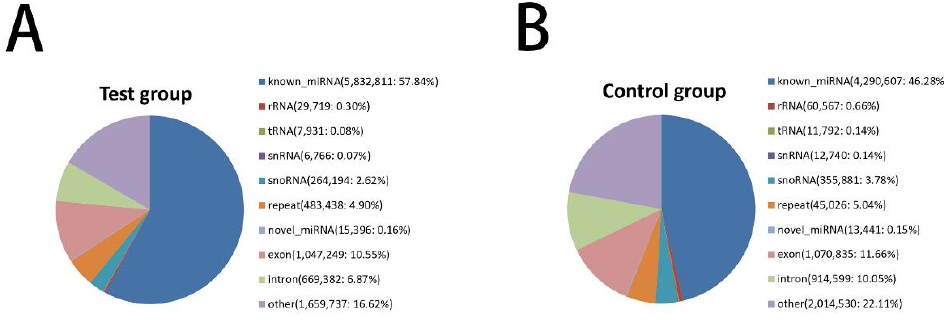
Figure 3. Small RNA classification notes. ( A ) Classification notes for test groups. ( B ) Classification notes for control groups.